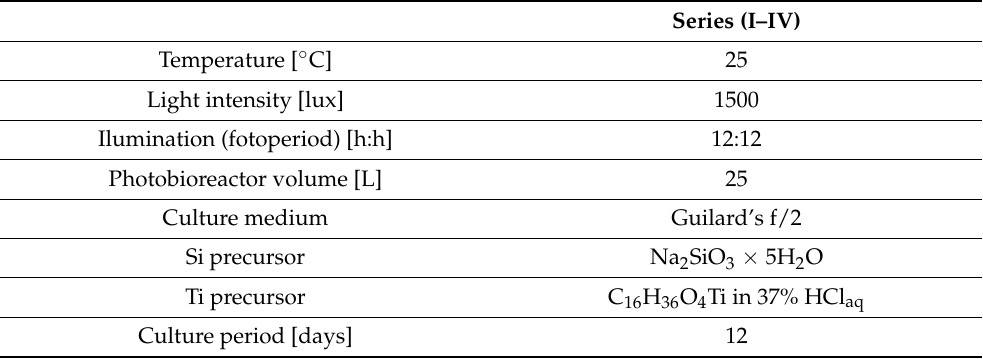
Table 1. Generalized set of cultivation conditions during the